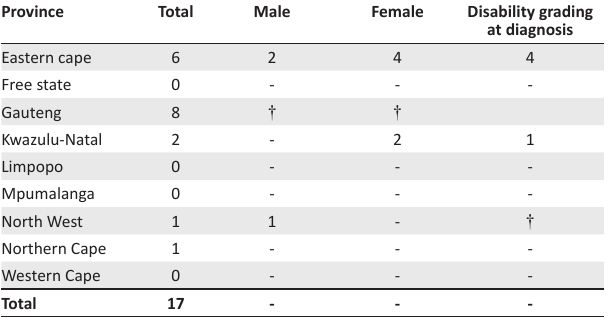
TABLE 1: Leprosy statistics (2020) in South